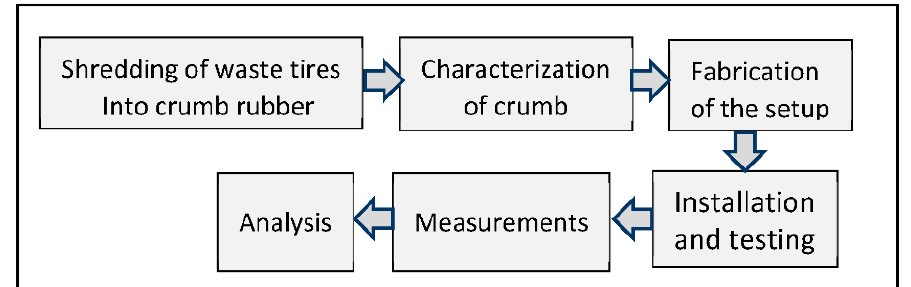
Figure 3. Research methodology.